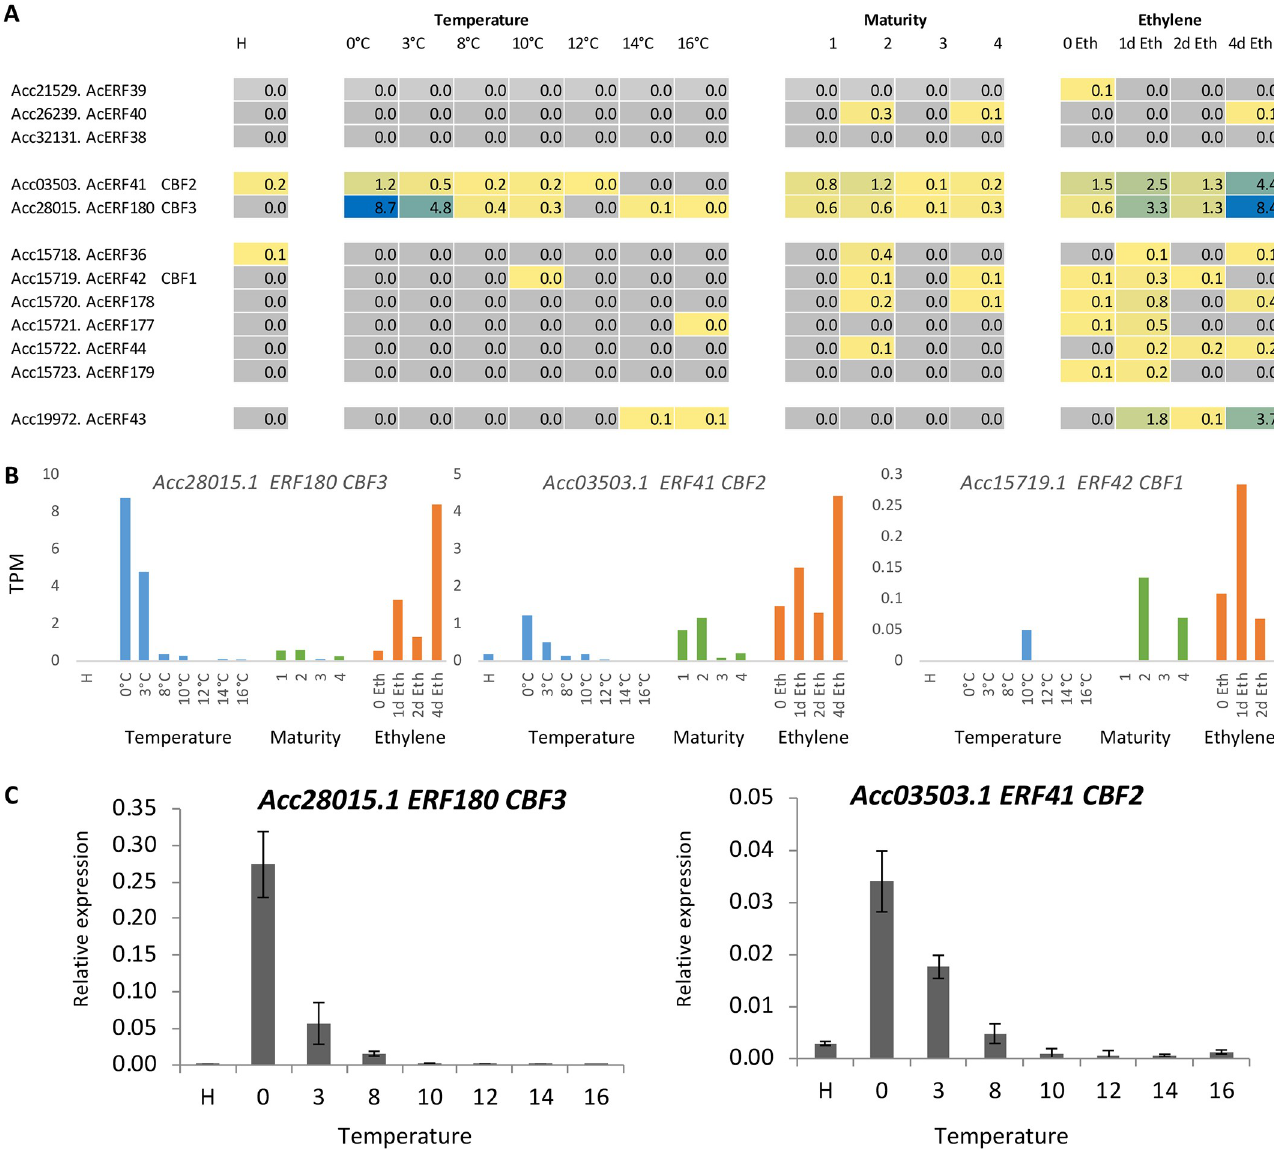
Fig 5. A. RNA-seq expression analysis of CBF -like genes in Actinidia chinensis var. chinensis ‘Hort16A’ kiwifruit, during fruit maturation and after ethylene (100ppm) and temperature treatments. B. Graphs of gene expression of two candidate CBF -like genes and the published CBF1 ( ERF42 ), showing the cold and ethylene control of expression. C. qPCR verification of the two cold-induced CBF genes, n = 4; ±